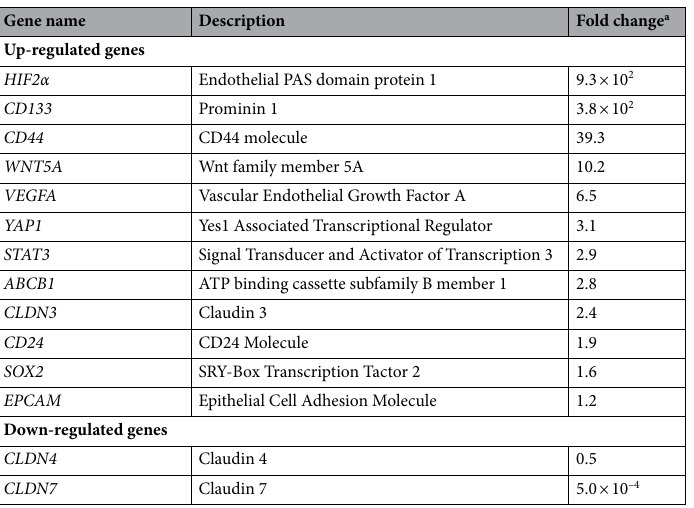
Table 1. Significant fold change variation of mRNA expression of candidate genes between DHSF-BR16 cells and MCF-7 cells. Data obtained by RT-qPCR analysis. a t test, p < 0.05.